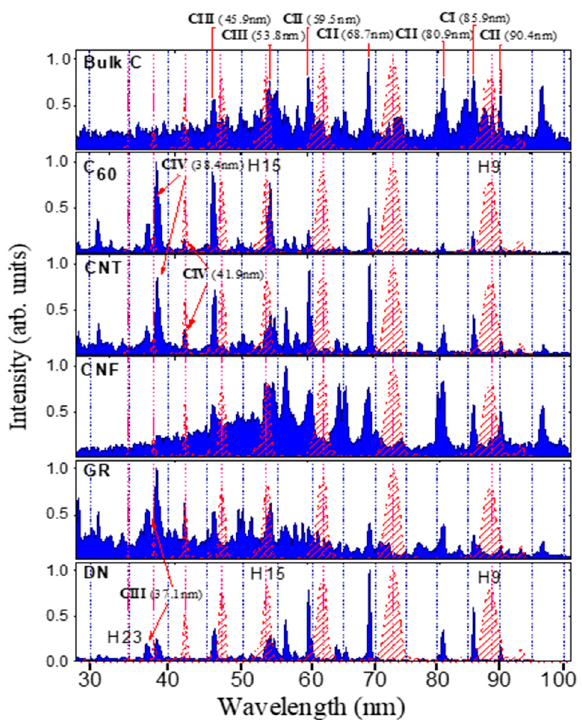
Figure 2. Spectral emission from different carbon-containing plasmas in the case of nanosecond laser ablation. The positions of harmonics (H9–H23) from 806 nm laser source are shown in red. In DN (E HP = 4 mJ) case, the plasma spectrum contained less emission lines and a smaller continuum despite the stronger excitation of the target. The different applied HP energies for different samples are explained by the different optimal conditions for plasma formation suitable for HHG. The term “optimal conditions” refers here to the maximal harmonic yield from each ablated sample, which depends on the fluence of HP on the target surface at similar geometry of the focusing conditions. Additionally, the pressed tablets were destroyed at higher fluencies of HP due to their fragility. For example, the harmonic yield from GR and DN LIPs was more than twice as small as from other targets due to weaker ablation at which the pressed tablets remain intact. Correspondingly, we could not increase the HP fluence on those fragile surfaces. As shown below, the ablation corresponded to the formation of low-ionized plasma using suitable fluence of HPs provided the conditions for efficient HHG. It is important to note that higher densities of free electrons cause the phase mismatch between the driv- ing and harmonics waves for overheated and strongly ionized plasmas, which plays a destructive role in HHG. The moderate fluencies of nanosecond pulses also increased the lifetime of the targets and provided better survival of the original nanostructures being ablated and spread in the plasma plume without their destruction. It was demonstrated that, in the case of laser ablation of C 60 , MW CNT, CNF, and DN [25] at the experimental conditions similar to ours, the transmission electron microscopy analysis of deposited de- bris has shown that laser-produced plumes contained the original nanostructures.